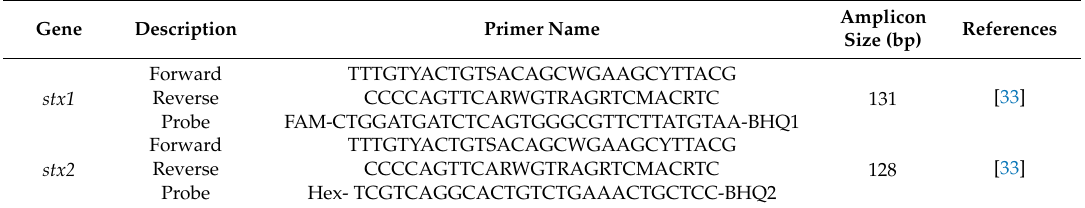
Table 1. Primers and probes used for the amplification of stx genes.